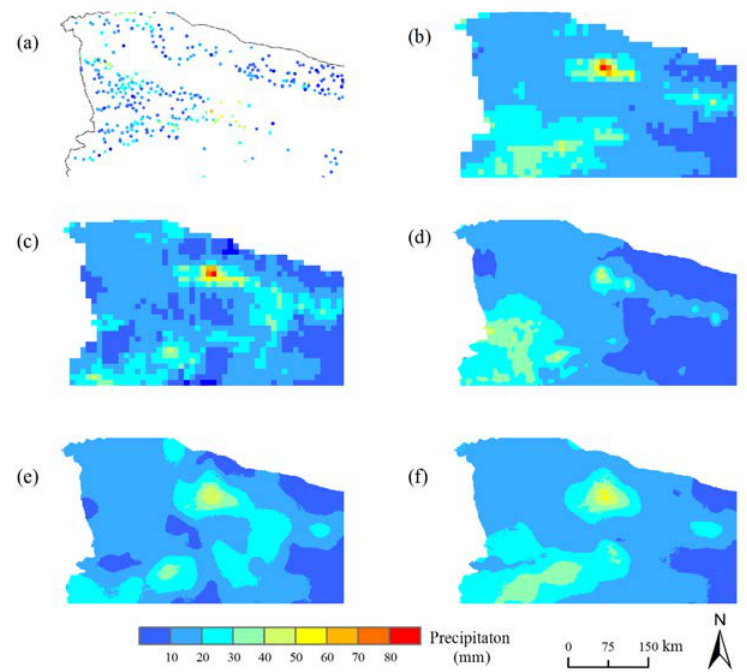
Figure 12. Enlarged views of the Ili Valley corresponding to Figure 11. ( a ) OBS; ( b ) OIMERG; ( c ) CIMERG; ( d ) DS_Spline; ( e ) DS_CIMERG; ( f ) DS_OIMERG.